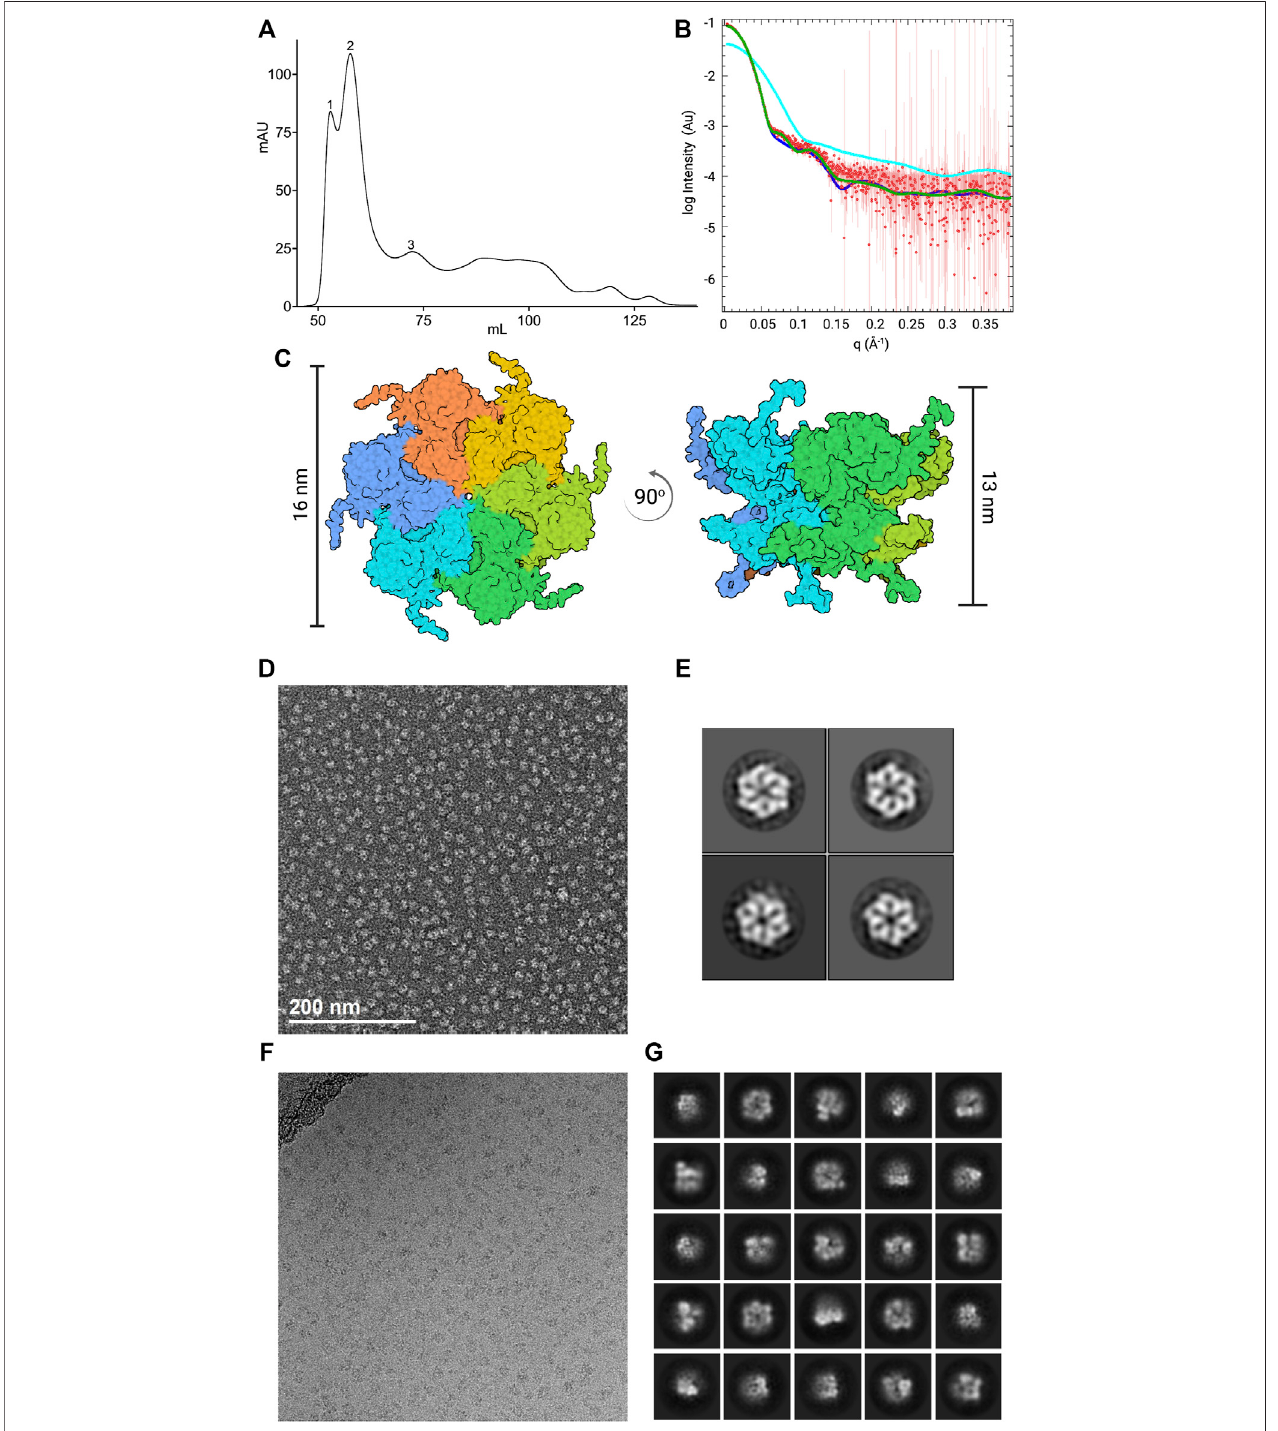
FIGURE 1 | Characterization of the initial CDC48A sample. (A) Size-exclusion chromatography pro fi le of CDC48A from the standard method of puri fi cation. Samples were analyzed using a HiLoad 16/600 Superdex 200 pg SEC column The tracerepresents absorbance at 280 nm. Based on the elution volume, the fi rst peak corresponds to aggregates, the second and highest peak corresponds to hexameric CDC48A, and the third peak to monomeric CDC48A. (B) SEC-SAXS curve of CDC48Asaturated withATP(red) overlaid withSAXS patterns calculatedfrom homology modelsbasedon theADP-ATP state ofp97(dark blue, PDB entry5FTN, χ 2 =2.28),theATP-ATPstateofp97(green,PDBentry5FTM, χ 2 =4.27),andanAlphaFold-derivedCDC48Amonomer(cyan, χ 2 =2585). (C) Topview(left)andsideview (right) of the best fi tting model from (B) , colored by chain. Vertical bars represent the diameter and height, respectively. (D) Representative image from the NS-EM screening. (E) Representative 2D class averages from the NS-EM screening. (F) Representative cryo-EM image from the initial dataset. (G) Representative 2D class averages from the initial cryo-EM